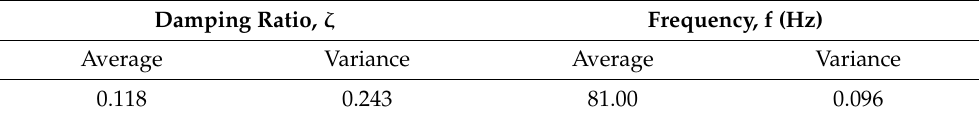
Table 4. SFRRC Impact specimens Damping Ratio, ζ and Frequency, f, Average and Variance.